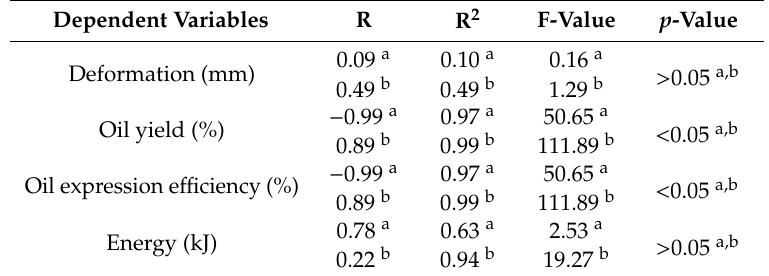
Table 6. ANOVA and correlation results of the e ff ect of speed and heat treatment temperature on the dependent variables.